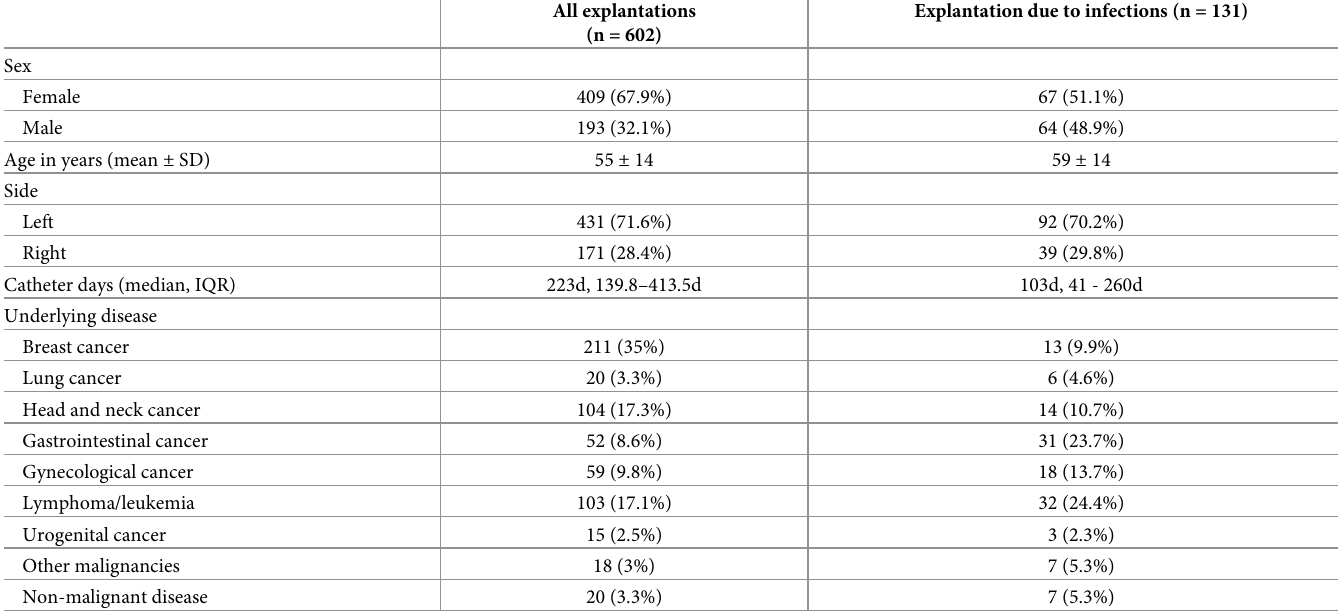
Table 1. Case characteristics of all upper arm port explantations and explantations due to infectious complications.